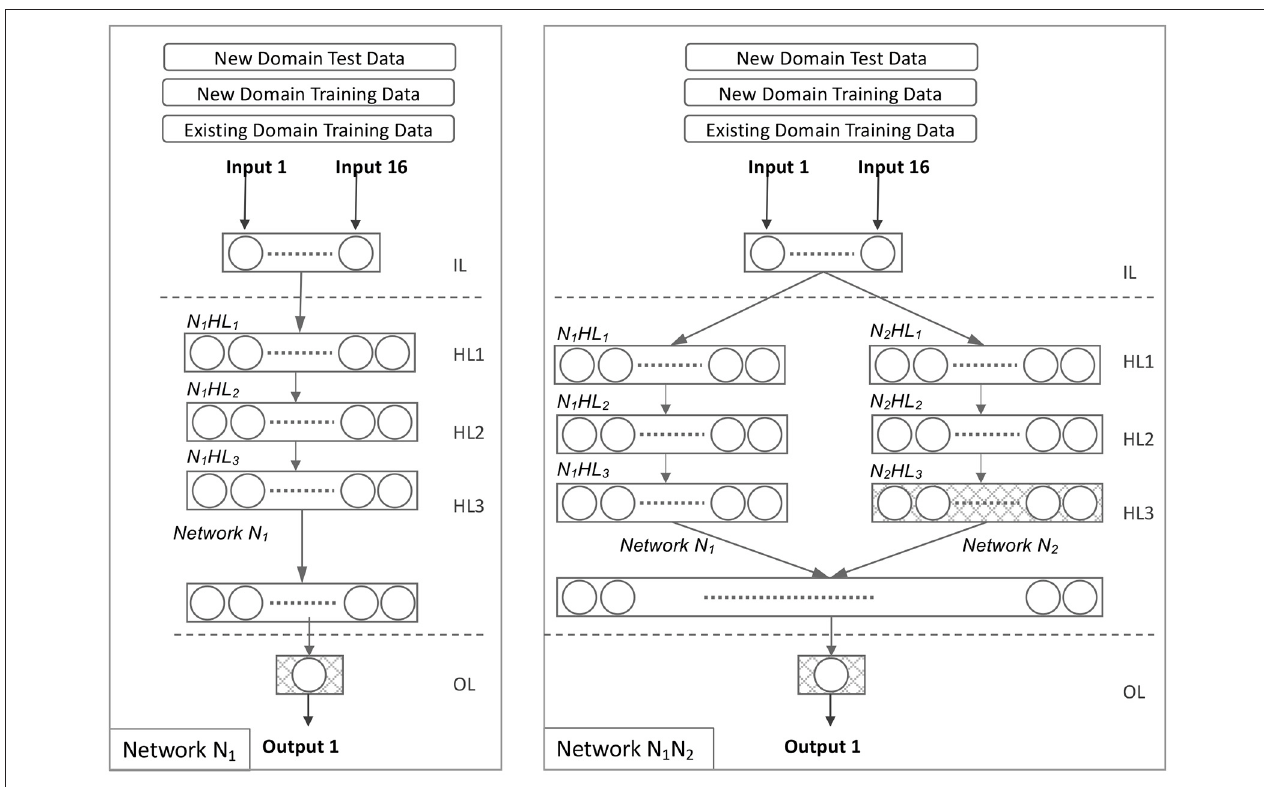
FIGURE 4 | Network N 1 and Network N 1 N 2